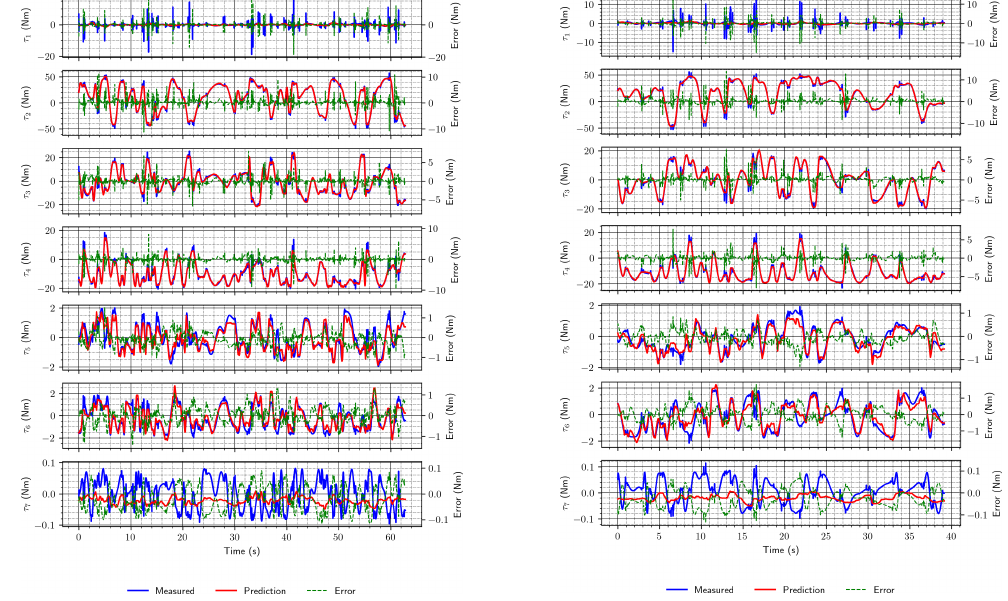
Figure 7. Two examples of torque estimates using the DeLaN architecture without external forces